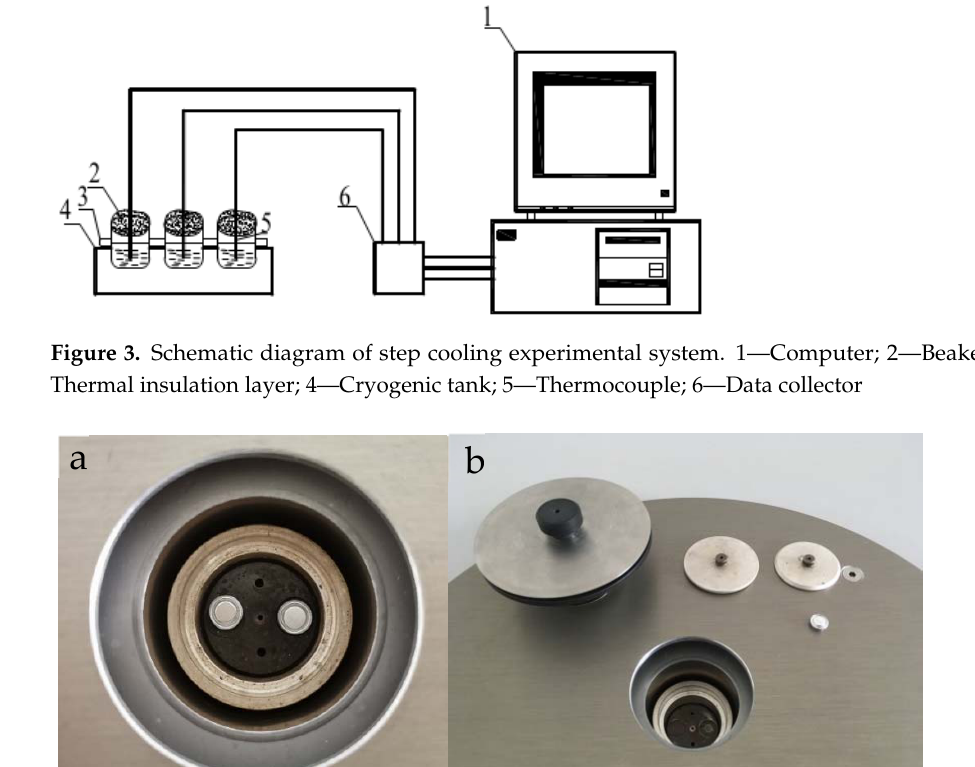
Figure 4. ( a ) Physical drawing of DSC test furnace cavity. ( b ) Reference sample (left) Test sample (right).